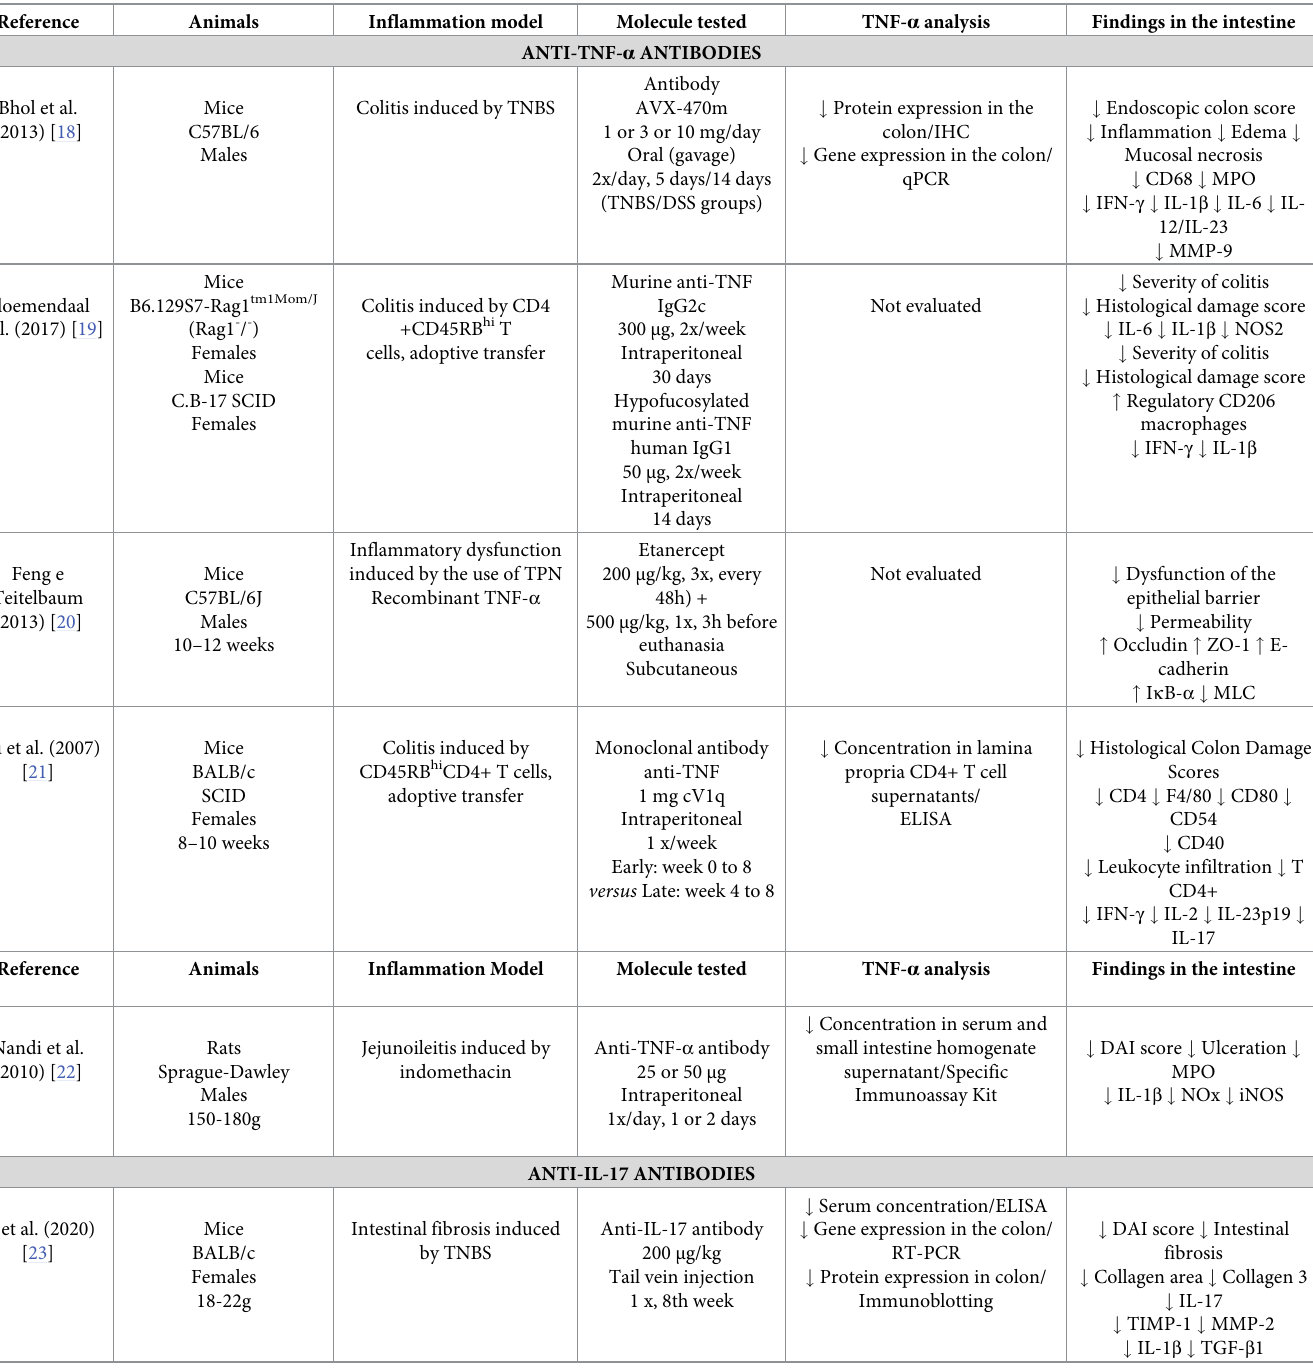
Table 3. Data extracted from the studies that were selected to compose the systematic